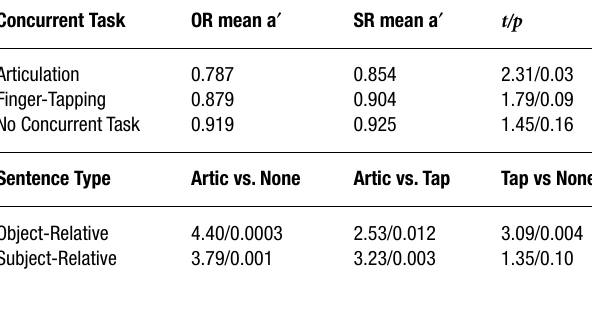
Figure 3 | Plausibility judgment performance for each sentence type in each concurrent task condition. Mean a ′ values across subjects for each sentence type in each task condition are depicted. Error bars represent 95% confi dence intervals. Table 2 | Summary of paired sample t -tests comparing plausibility judg- ment performance (a ′ values averaged across subjects) for object-relative sentences and for subject-relative sentences during each concurrent task condition, as well as pair-wise comparisons for performance on each sen- tence type across concurrent task